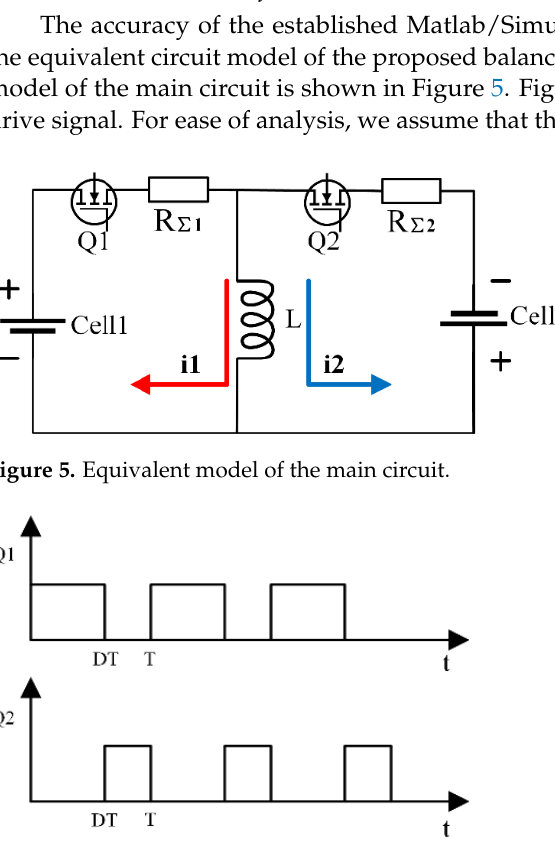
Figure 6. Drive signal waveform of MOS transistors.